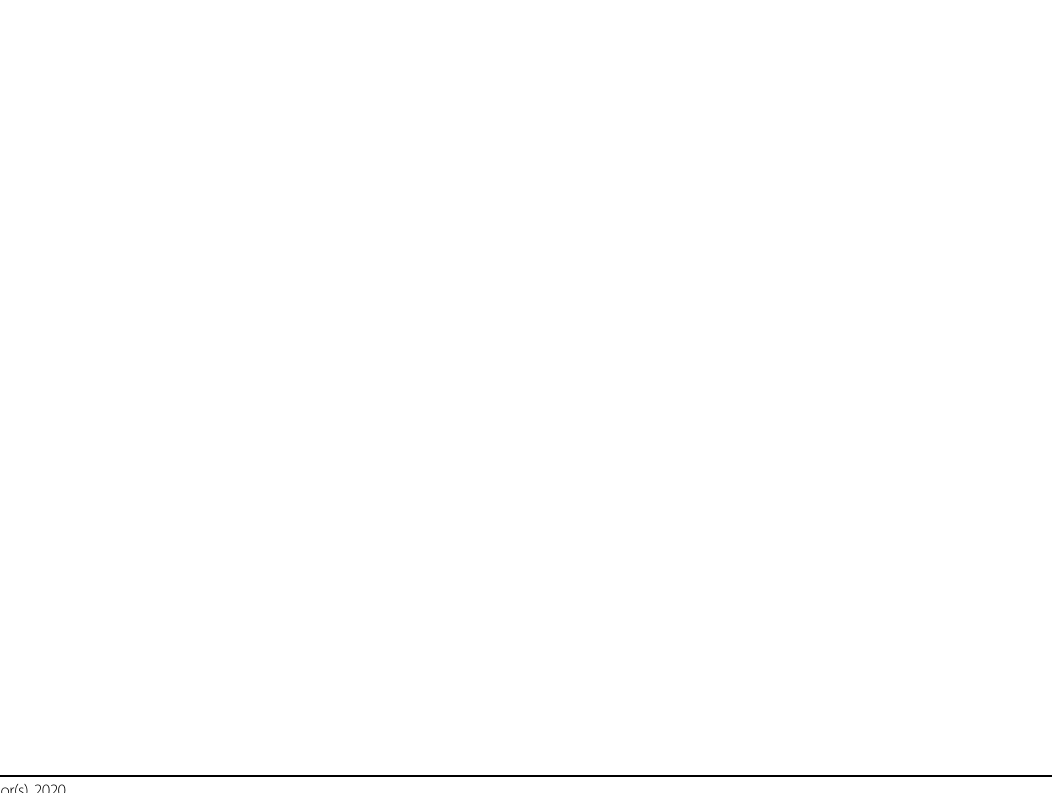
compilation of Fig. 6c, which was caused during manu- script preparation. The correct Fig. 6 is shown below. The authors apologise for the error, and con fi rm that this does not affect the conclusions of the